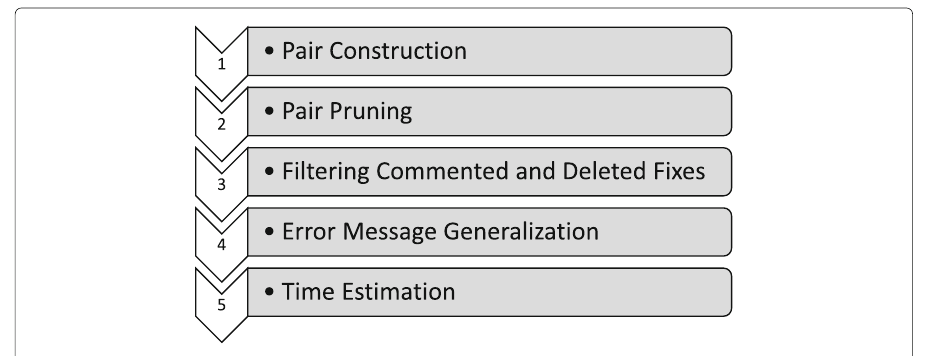
Fig. 3 The steps in preparing a set of compilation pairings